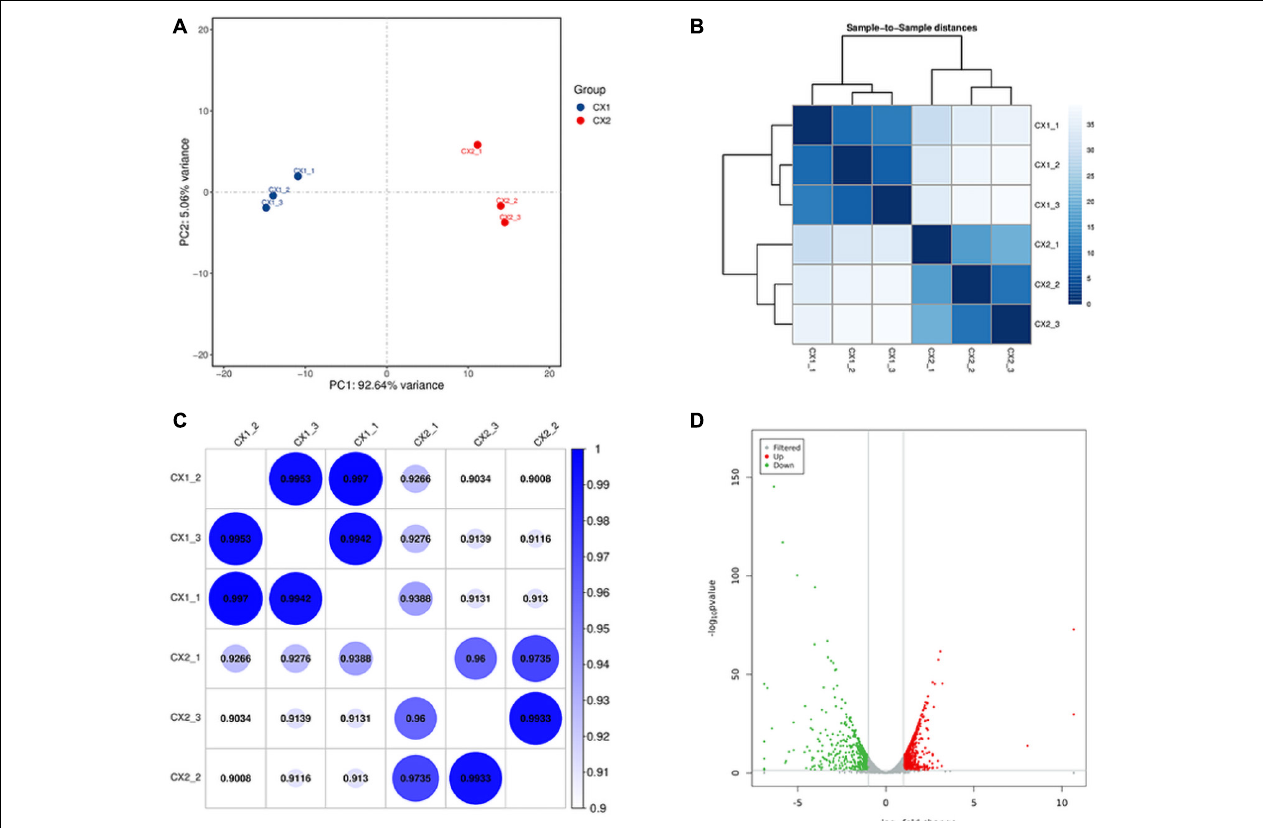
FIGURE 1 | Validation of C. auris transcriptome. (A) Principal component analysis (PCA) plot showing the level of correlation among CX1 (blue) and CX2 (red). The closer the PCA plot distance is, the more similar the samples are. (B) Cluster analysis of gene expression data. The chromaticity of the color represents the size of the correlation coefficient. (C) Heat map of correlation coefficient between samples. The color represents the size of the correlation coefficient. (D) Volcano plot. Every dot represents a differentially expressed gene. Gray dots were non-significantly different genes, and the green and red dots were significantly upregulated different genes in CX1 and CX2,